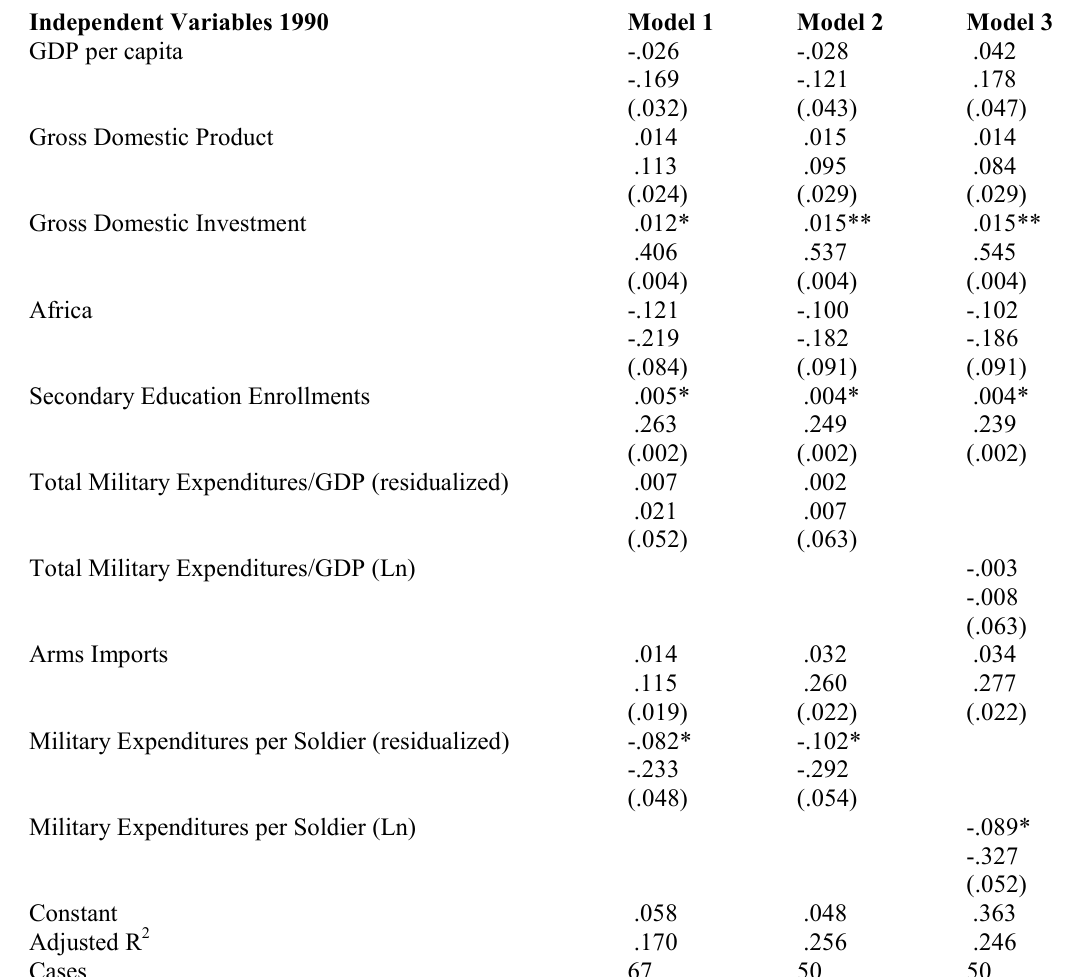
Table 1: Unstandardized Coefficients from the Regression of GDP per capita Growth 1990-2003 on Military Expenditures per Soldier and Other Independent Variables in 1990: All Countries (Model 1) and Less Developed Countries Only (Models 2 and